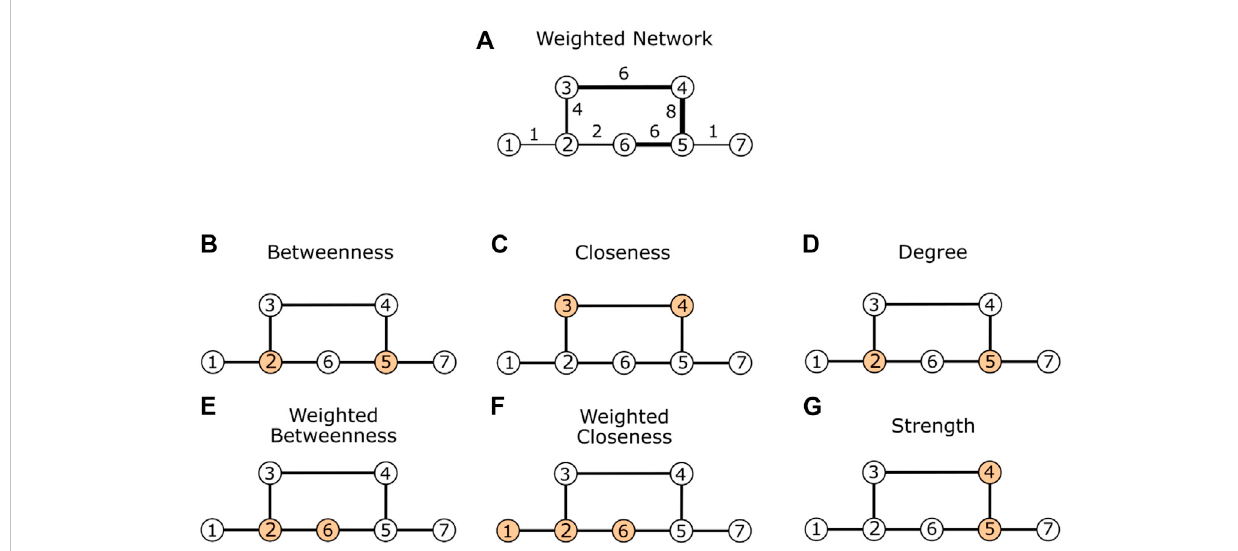
FIGURE 4 Node centrality ranking inbinaryand weighted networks.Orange nodes identify thehighestcentrality valuenodes. (A) A weighted network with link weights as proximity. (B) First two nodes with a higher binary betweenness. (C) First two nodes with a higher binary closeness. (D) First two nodes with a higher degree. (E) First two nodes with higher weighted betweenness. (F) First three nodes with a higher weighted closeness. (G) First two nodes with higher strength. Passing from binary to weighted node centralities, the node rank changes as